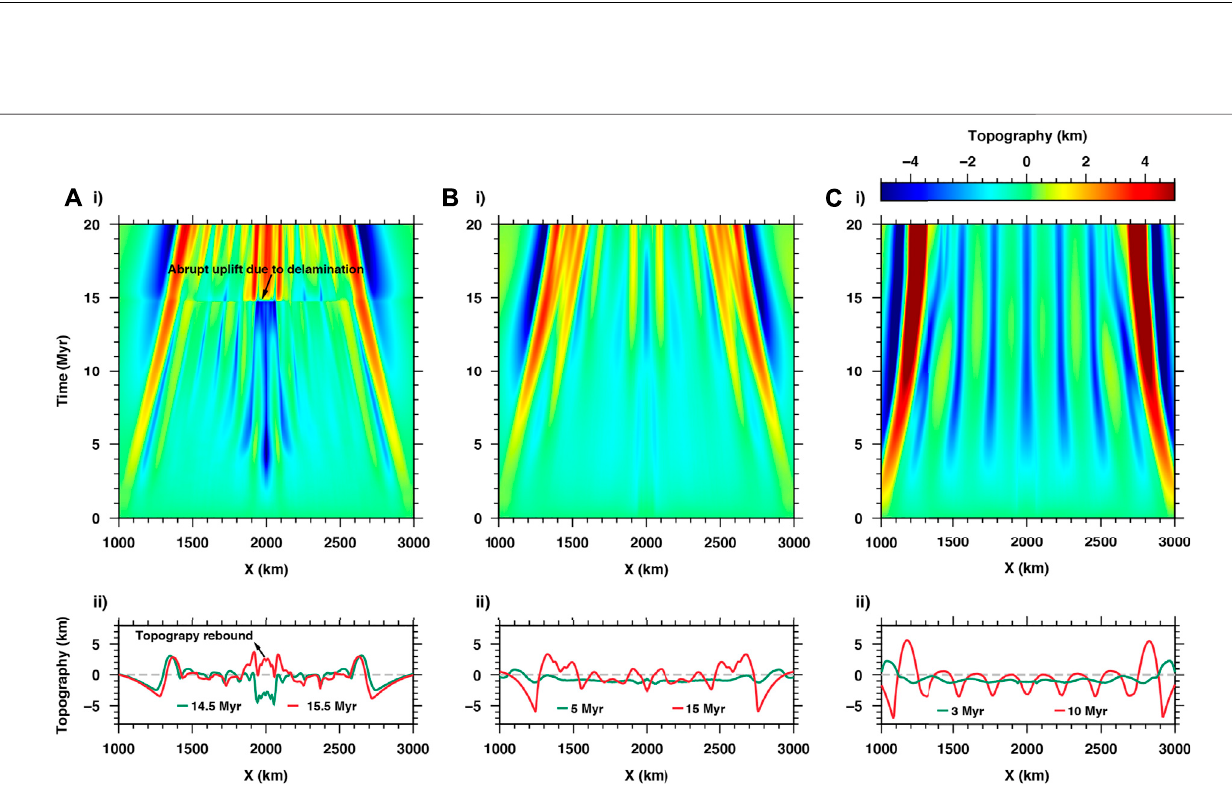
Frontiers in Earth Science |